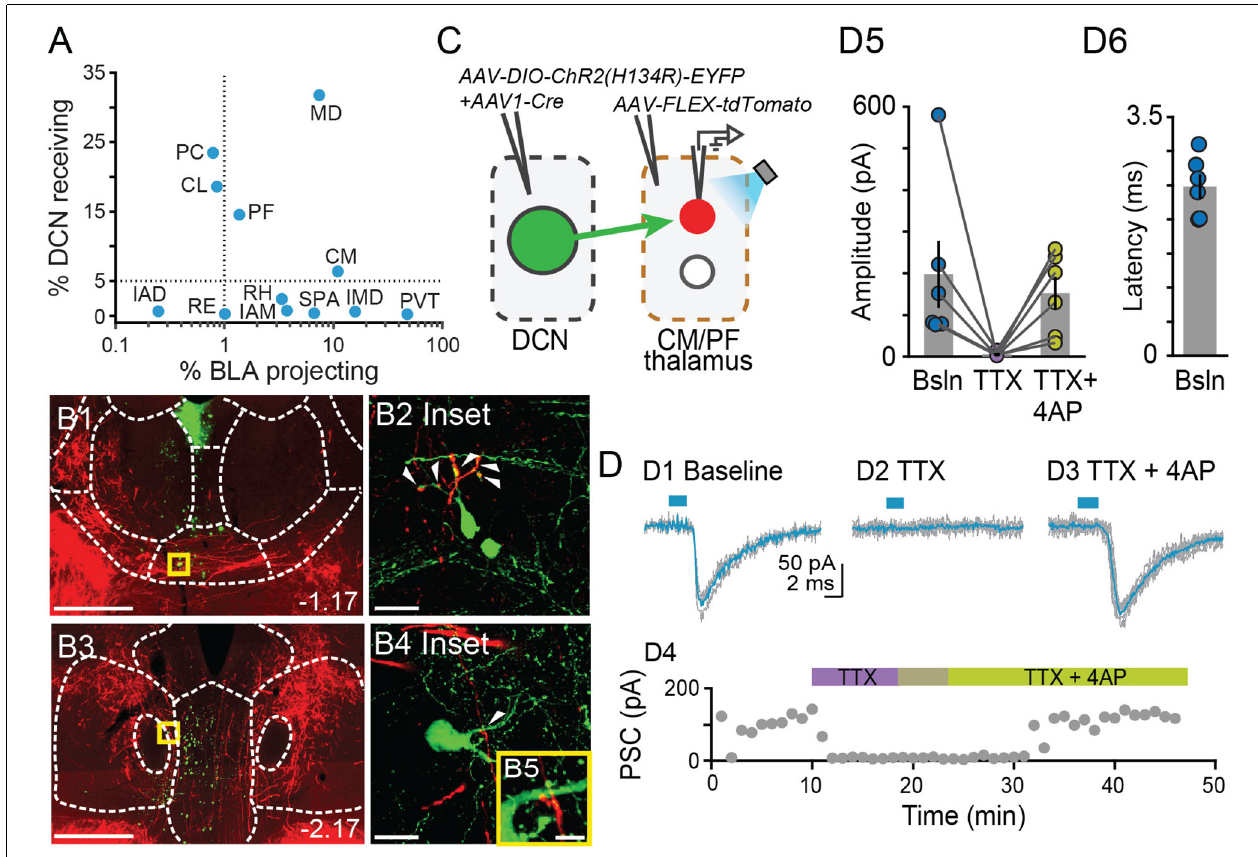
FIGURE 5 | Centromedial and parafascicular neurons project to the basolateral amygdala and receive functional monosynaptic input from the cerebellum. (A) Scatterplot of % neurons receiving DCN input vs. % neurons projecting to BLA, for limbic thalamus nuclei. (B1–B4) Airyscan confocal images of DCN axons (red) and BLA-projecting neurons (green) in the centromedial (CM; B1 ) and parafascicular (PF; B3 ) thalamic nuclei. (B2,B4,B5) Zoomed-in areas in yellow squares from (B1,B3) . Scale bars: (B1,B3) : 500 µ m; (B2,B4) : 20 µ m; (B5) : 5 µ m. (C) Schematic diagram of ex vivo optophysiology approach to test for monosynaptic connections between DCN and CM/PF thalamic n. (D1–D3) Average ChR2-evoked synaptic current (teal), overlaid onto single trial responses (gray), at baseline (D1) ; upon addition of the action potential blocker tetrodotoxin (TTX, 1 µ m; D2 ); after further addition of the potassium channel blocker 4-aminopyridine (4AP, 100 µ m; D3 ). (D4) Time course of the wash-in experiment for the same example cell. (D5) Summary of effects on amplitude (mean ± SEM) of ChR2-evoked synaptic responses for the indicated conditions. Bsln: baseline. (D6) Average ( ± SEM) onset latency of ChR2-evoked responses at